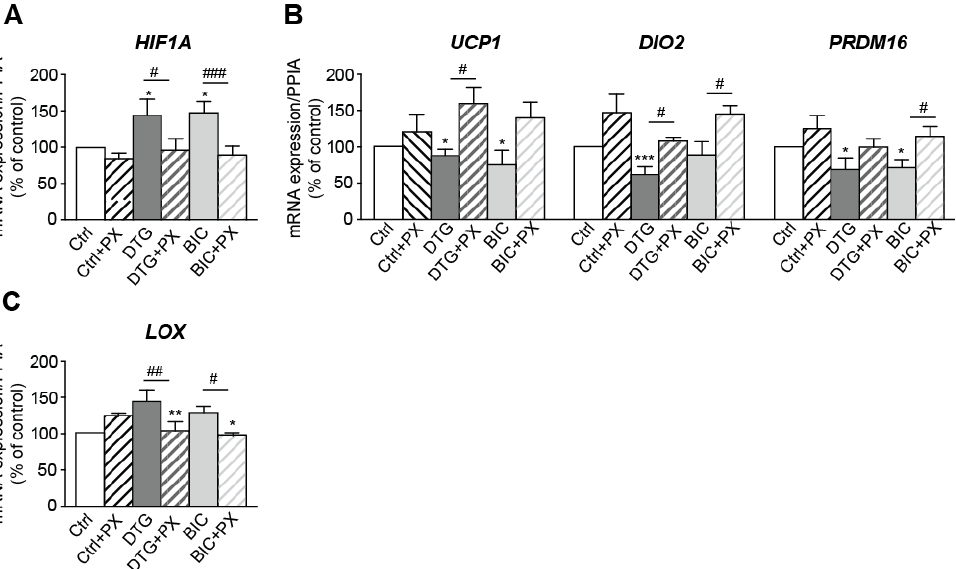
Figure 7. The inhibition of HIF1A by PX478 prevented the deleterious effects of INSTIs on beiging and fibrosis. ASCs were concomitantly treated with INSTIs and PX478 (HIF-1 α inhibitor) throughout the differentiation process. The relative mRNA expression levels of ( A ) HIF1A , ( B ) UCP1, DIO2; PRDM16 , and ( C ) LOX were normalized against that of PPIA. The results are expressed as the mean ± SEM % of control cells (n = 3, in duplicate ). * p < 0.05, ** p < 0.01, *** p < 0.001 vs. control cells. # p < 0.05, ## p < 0.01 , ### p < 0.001 PX478-treated vs. non treated cells.